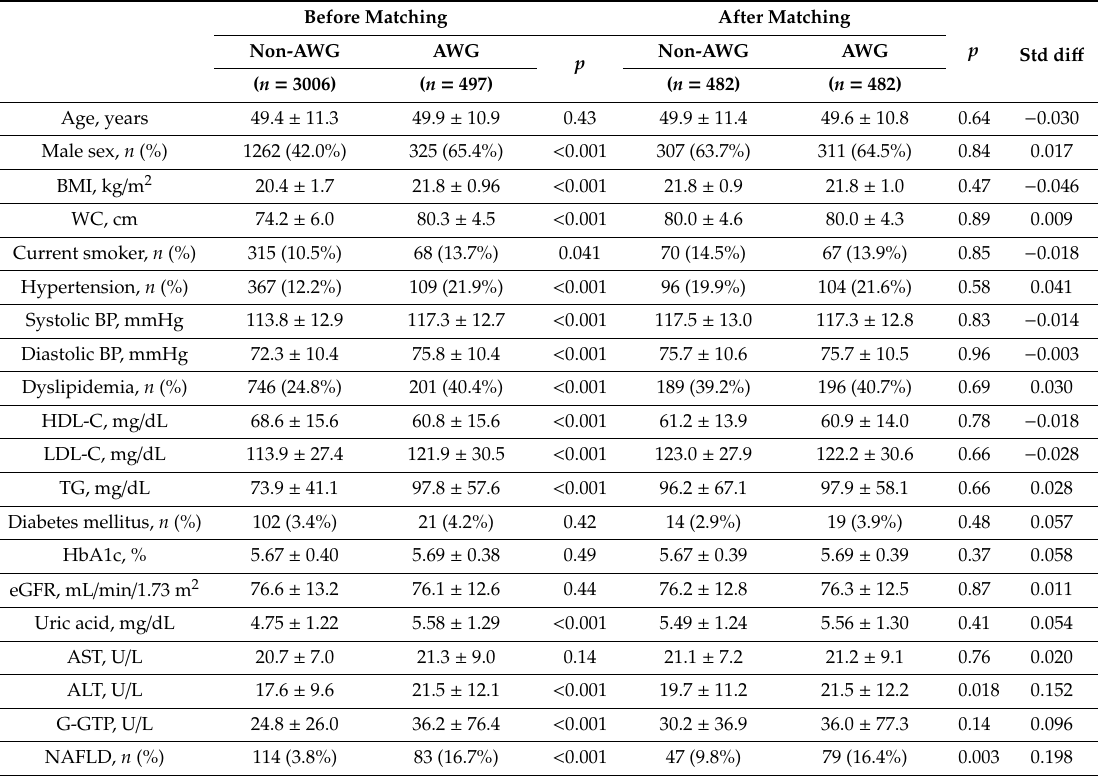
Table 2. Comparison of clinical and metabolic parameters between participants with and without AWG. Before Matching After Matching